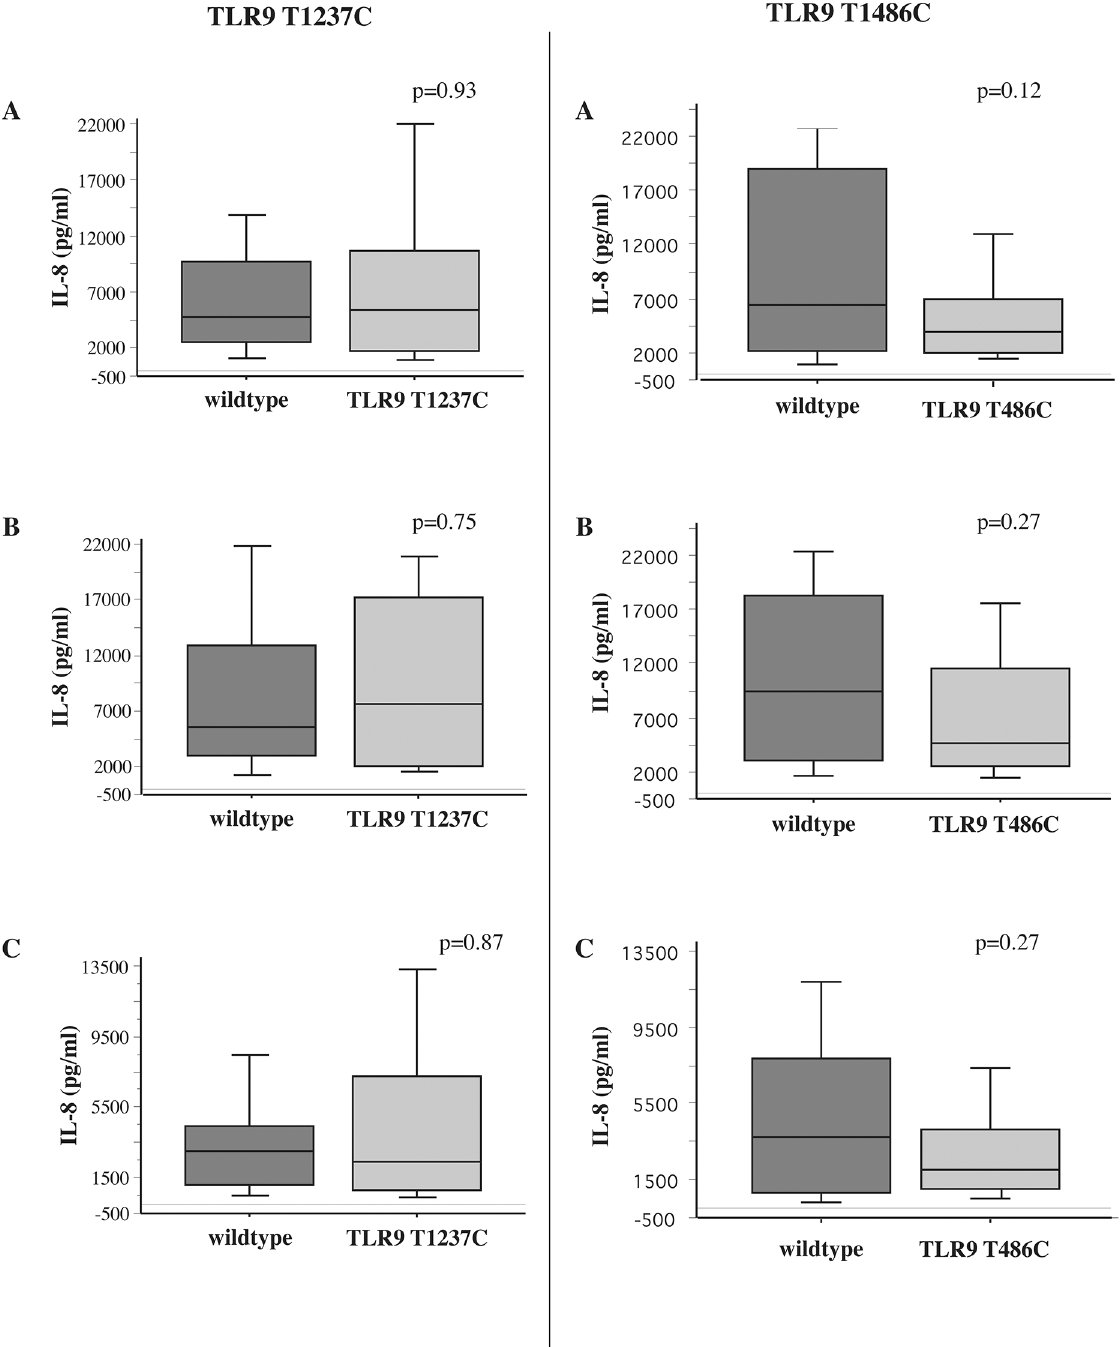
Fig 3. Association of TLR9 SNPs and bacterial induction of COPD active smoker alveolar macrophage IL-8. Supernatant IL-8 concentrations of alveolar macrophages, obtained from active smokers with COPD, incubated with the same three bacterial strains detailed in Fig 3, were measured. Shadings for wildtype, TLR9 (T1237C), and for TLR9 (T1486C) are as detailed in Fig